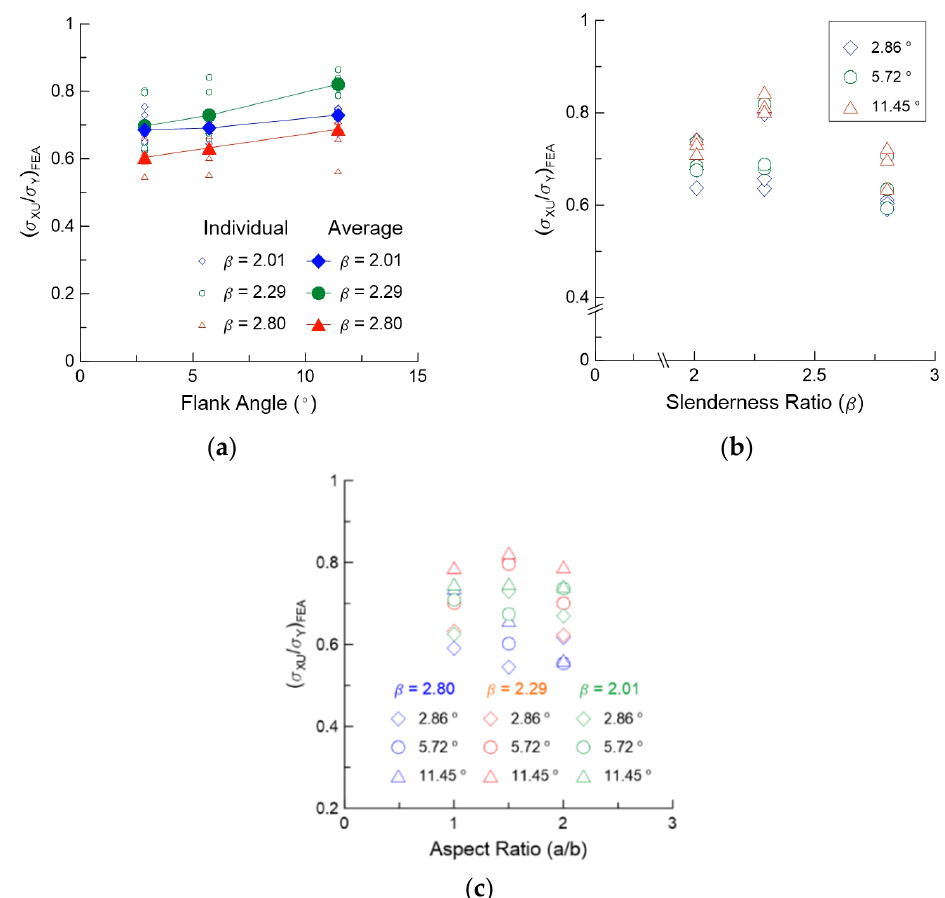
Figure 8. Ultimate strength of the curved plates based on the results of experiments: ( a ) effect of flank angle, ( b ) slender-ness ratio, and ( c ) aspect ratio.